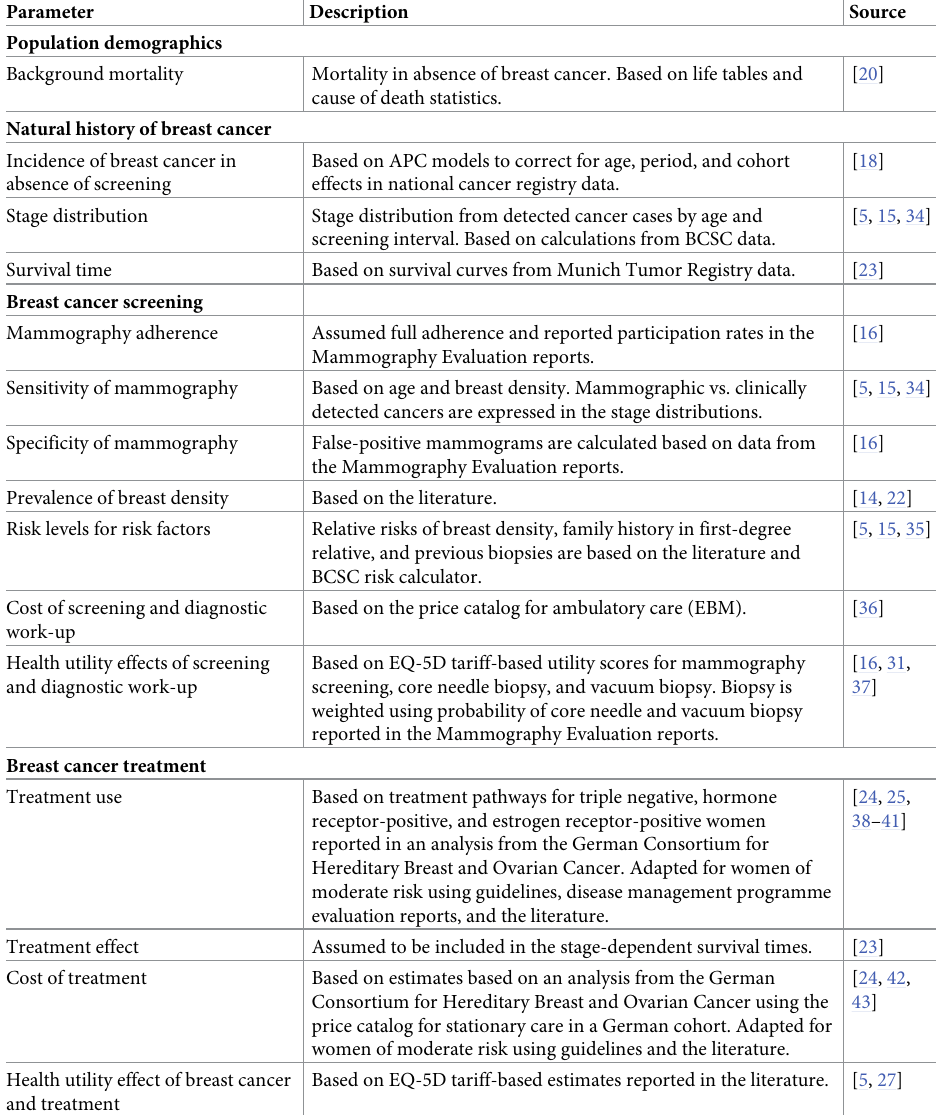
Table 1. Model input